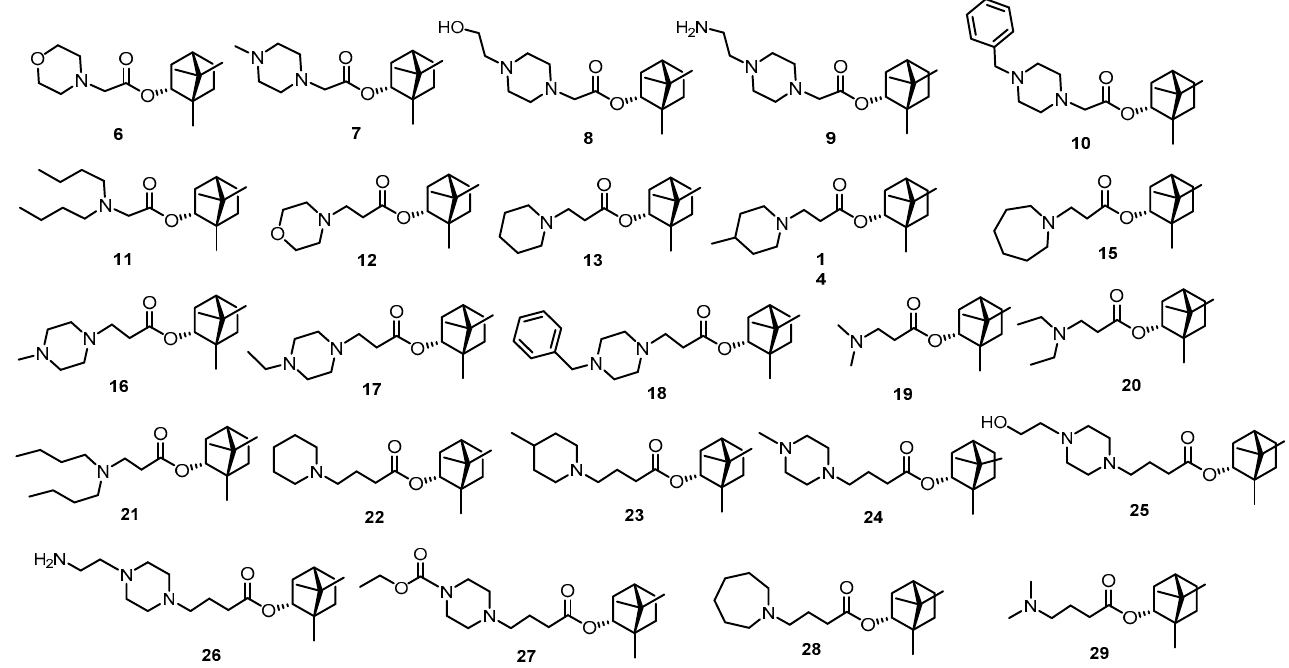
Figure 4. Compounds of the second class—ester derivatives based on (-)-borneol.